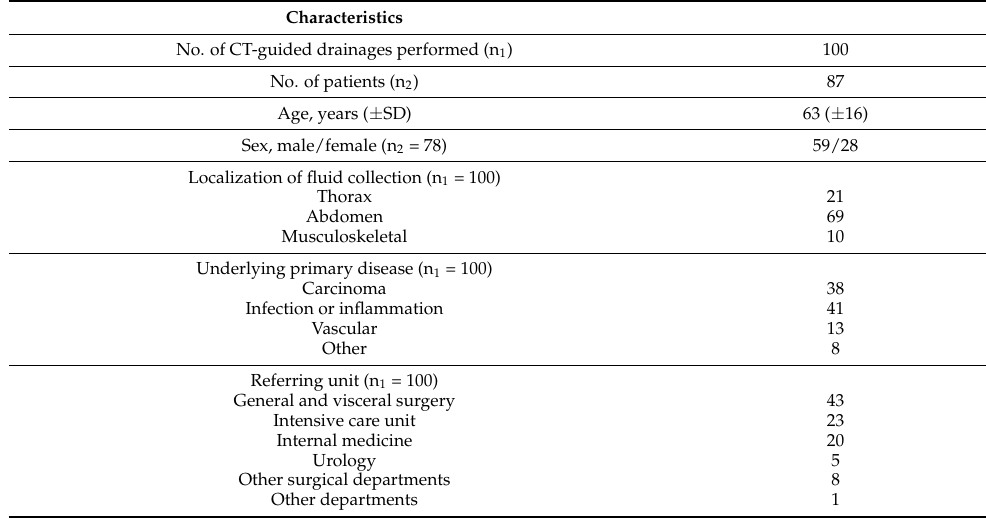
Table 1. Demographic data of patients with fluid